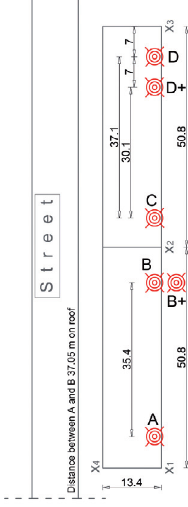
Figure 10. (a) Satellite image and (b) simplified building floor plan of KIS (Figure 2,VII), showing the locations of the installed stations (red symbols).